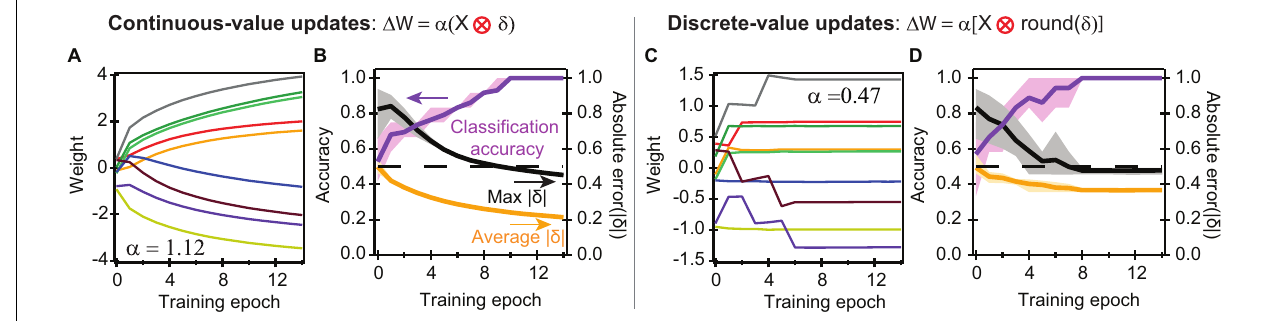
FIGURE 3 | Convergence of perceptron operations using different learning rules. (A) Weight updates of the nine synapses using stochastic gradient descent to solve for AND, OR, and NAND logic gate functions. The cross-entropy cost function with continuous-value weight updates was used, such that ∂ L ∂ Z = Y-A = δ . (B) Average accuracy and absolute error to train six different initial seed values; the shaded areas represent the range of values taken by the six seeds. It takes about ten training epochs to fully classify the problem. Our learning rule states that an absolute error | δ | less than 0.5 is a correct classification. The average absolute error takes the mean absolute error | δ | of the 12 operations defined in Figure 2A in each training epoch; the max error is the maximum error of the 12 classification operations. Convergence is defined as when the classification accuracy is 100%, or when the maximum error is less than 0.5. (C) Experimental training when using discrete-value weight updates: positive, negative, or 0. (D) Convergence, accuracy, and error for discrete-value updates, with the same colors defined in (B) . The colors in (A,C) are the same as the ones defined in Figure 1C